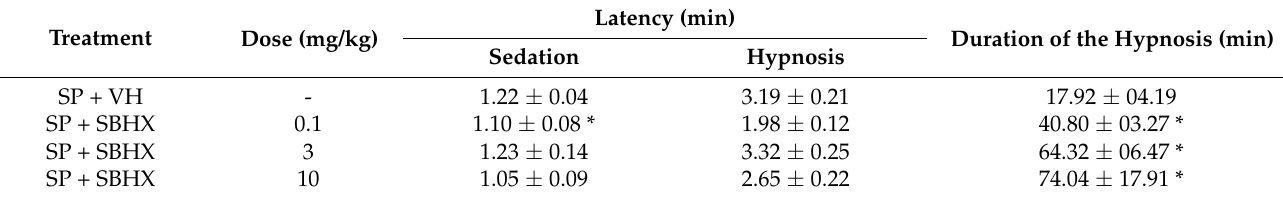
Figure 1. Pharmacological evaluation of the behavioral responses in the open-field ( A ), hole-board ( B ), and elevated plus-maze ( C ) tests in mice receiving SBHX (30 or 300mg/kg, i.p.) in comparison to the vehicle group and the reference drug diazepam (DZP, 0.1mg/kg, i.p.). Bars represent the mean ± SEM of five mice ( n = 5). * p < 0.05, *** p < 0.001, ANOVA followed by Dunnett’s test. SBHX: Hexane Extract of B. excelsa seeds. Table 1. Sodium pentobarbital (42 mg/kg)-induced hypnotic potentiation in the presence of the Bertholletia excelsa seed extract (SBHX) and diazepam (DZP) in